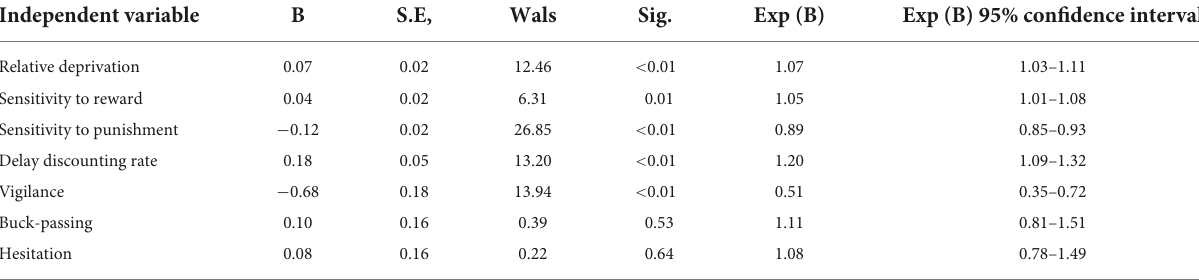
TABLE 3 Logistics regression analysis of decision-making differences against offending ( n =